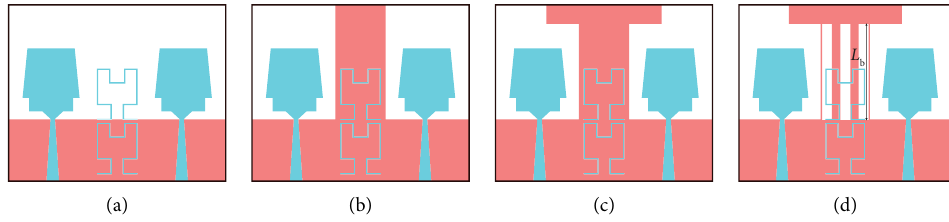
Figure 6: Evolution of the SWB-MIMO antenna decoupling structure. (a) Antenna 5. (b) Antenna 6. (c) Antenna 7. (d) Antenna 8.